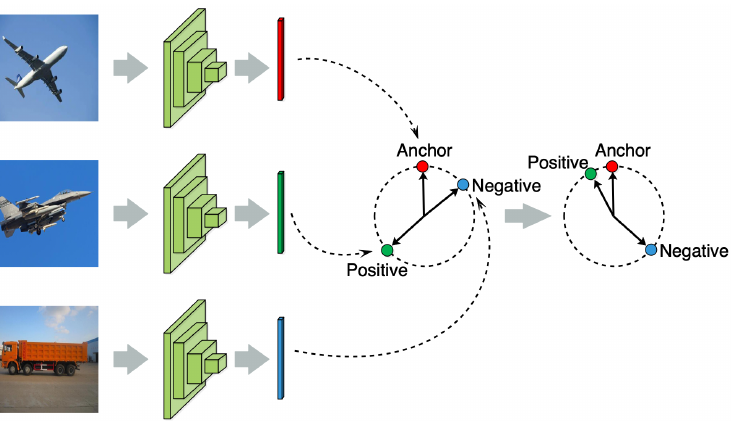
Figure 2. An illustration of the influence of triplet loss on visual feature